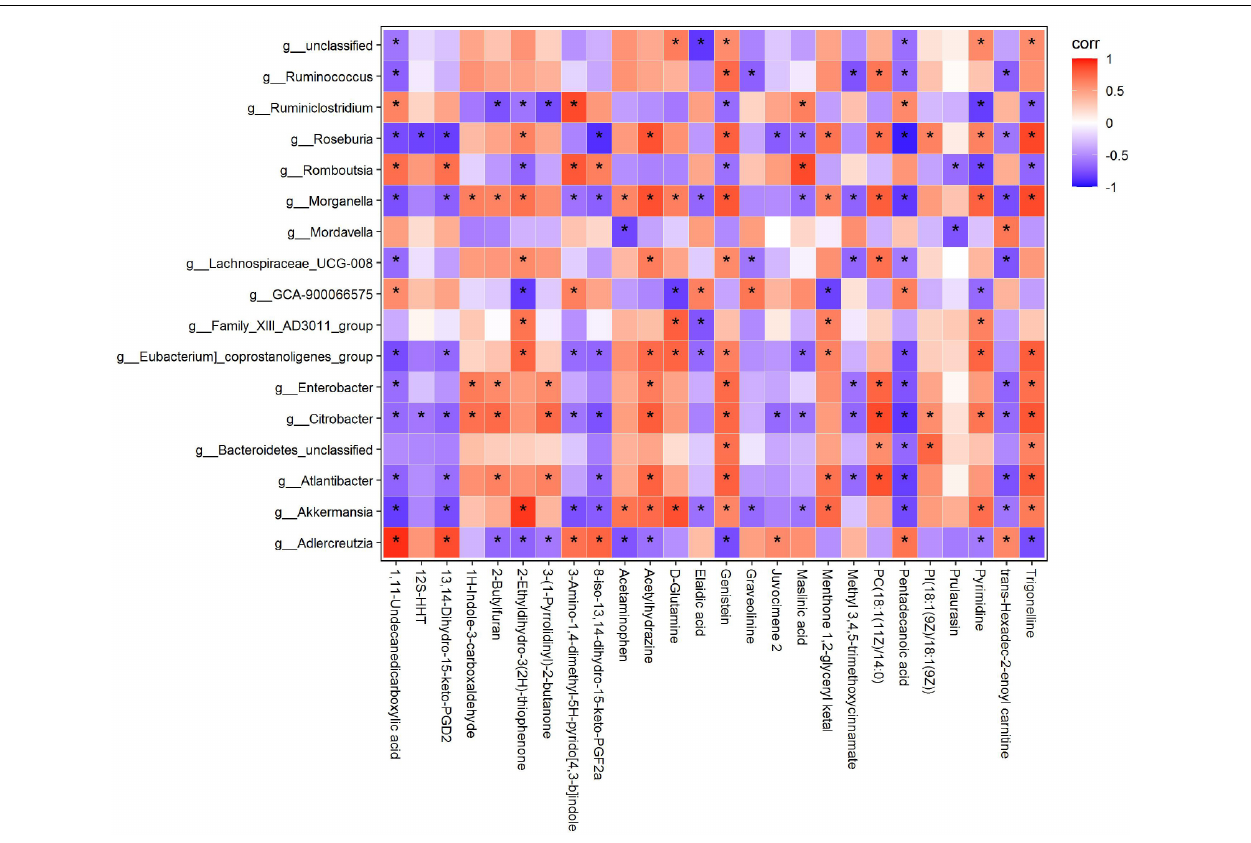
FIGURE 9 | Correlation analysis of intestinal flora and metabolites ( n = 6). * P <